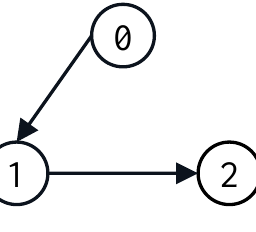
Figure 6. The directed communication graph.